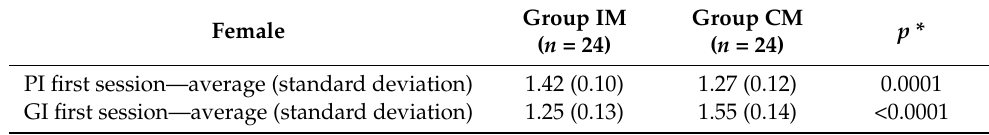
Table 8. Average (standard deviation) of PI and GI in the first monitoring session in female patients.